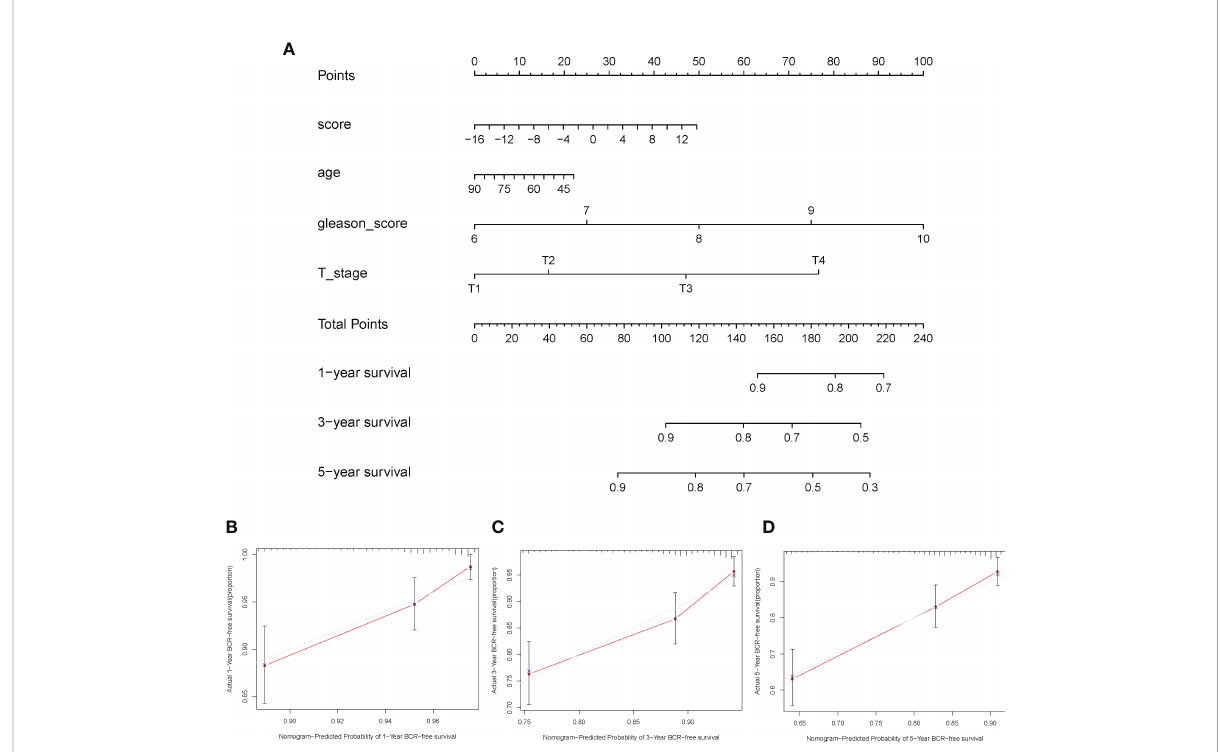
FIGURE 8 Construction of nomogram for prostate cancer. (A) The nomogram was based on immune cell in fi ltration score, age, Gleason score, and T stage to predict the prognosis of 1, 3, and 5 years. (B – D) The 1-year (B) , 3-year (C) , and 5-year (D) calibration curves of the